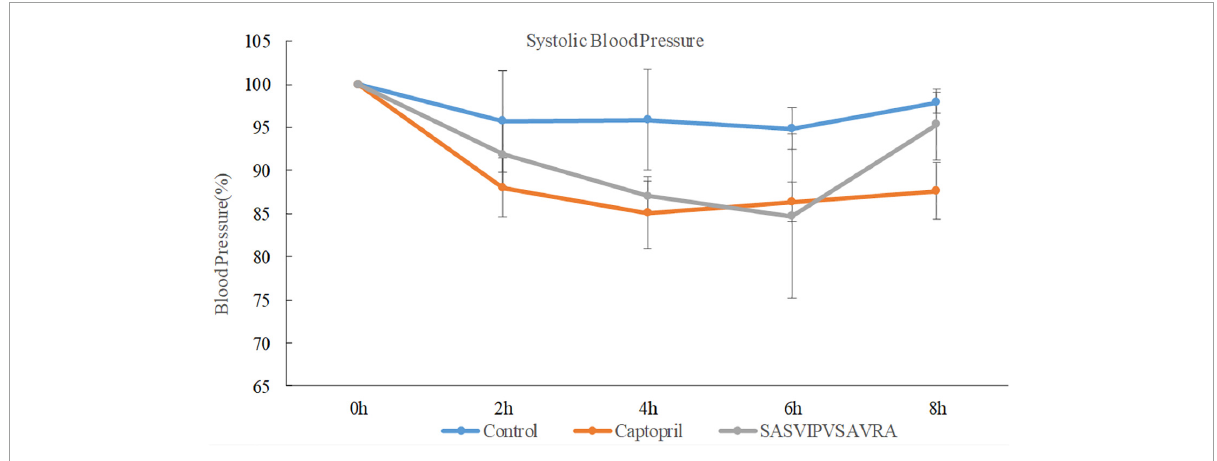
FIGURE6 The effects of distilled water, captopril and SASVIPVSAVRA on systolic blood pressure of